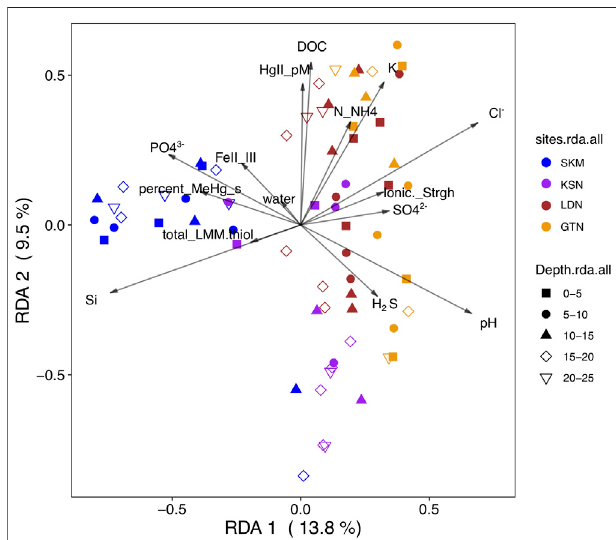
FIGURE 3 | RDA biplot (2 fi rst components) of the Hg II methylating microbial community ( hgcA gene, OTU level) (response variable) constrained by physicochemical variables (predicting variable) and the studied sites (SKM, KSN, LDN, and GTN). The color-coding in the legend indicates the differentsites.Theshapescorrespondtowetlandcoredepth.Thearrowsand text summarize explanatory